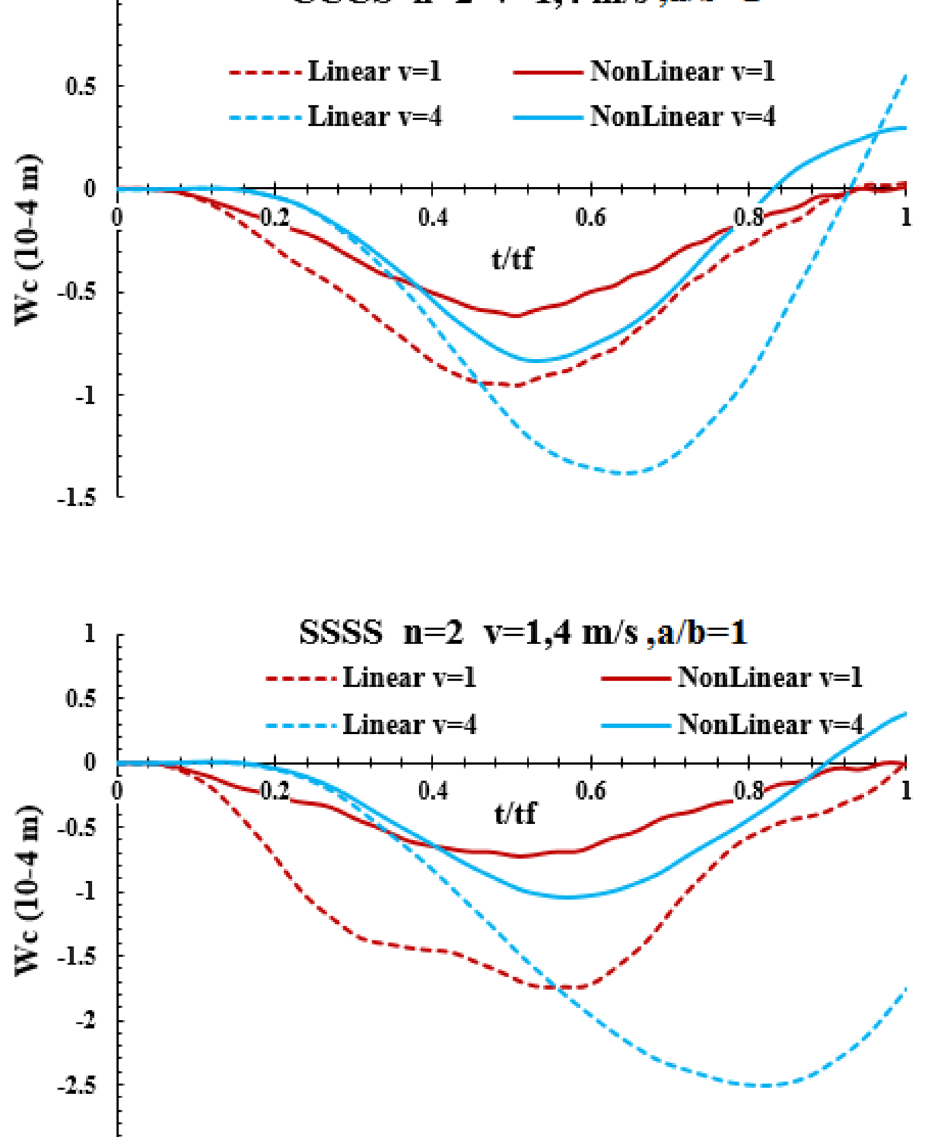
Fig. 7 The effect of velocity of moving force on deflection history of center-point of the plate (CCCS boundary condi- tion)